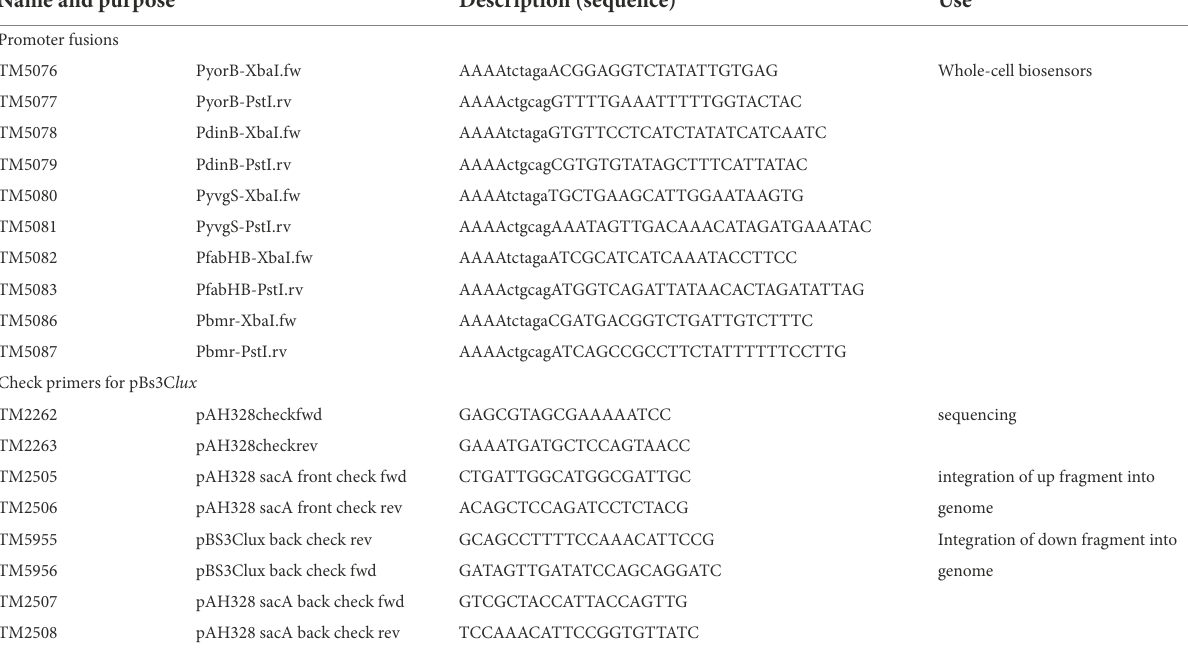
TABLE 5 Oligonucleotides used in this